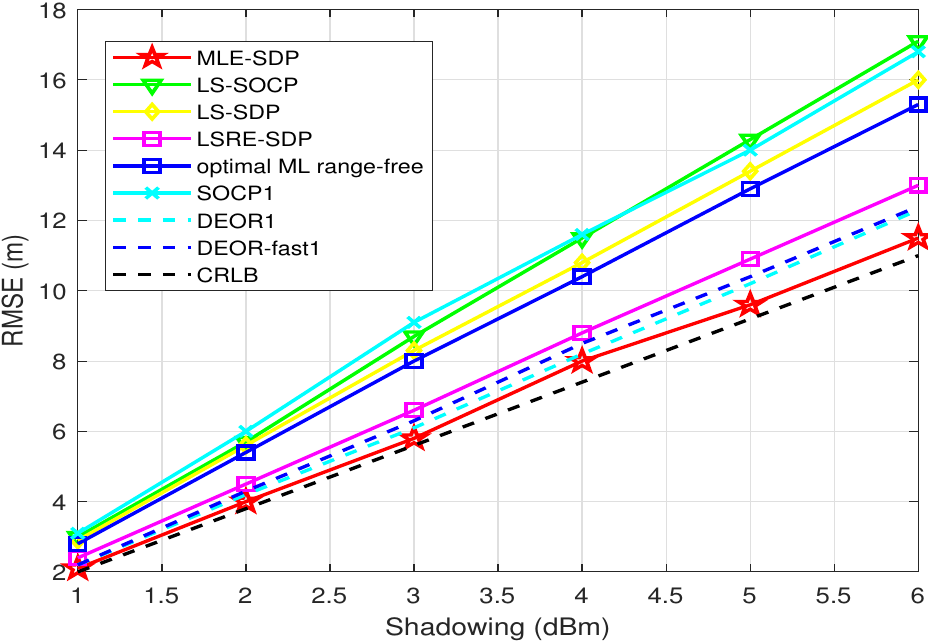
Figure 2. When L 0 is known, this is the relationship between RMSE and σ n